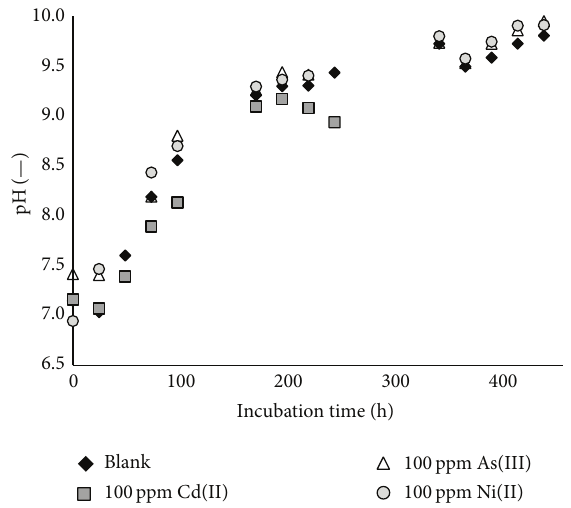
Figure5:VariationofpHduringgrowthof Bacillusmucilaginosus in ablanknutrientbrothmediumandundermetalstressfrom100 ppm Cd(II) (0.9mM), As(III) (1.3mM), or Ni(II) (1.7mM)